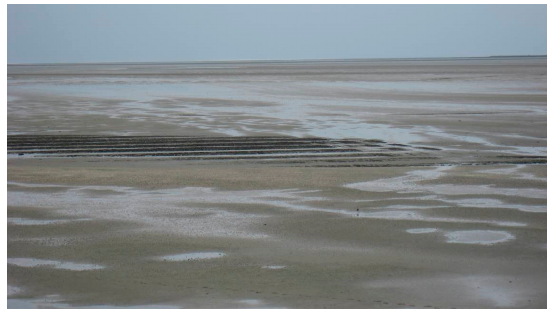
Figure 12. Photograph of the study area north of the red arrow in Figure 11. The picture was taken at